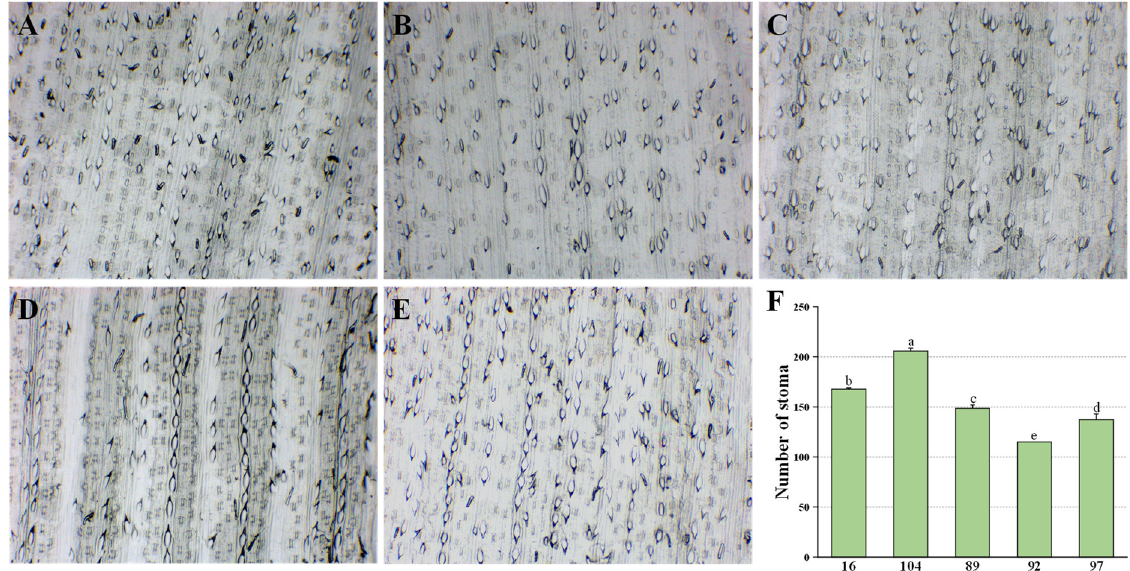
Figure 5. Microscopic observation of the stomata on sugarcane leaves in transgenic and control sugarcane lines. ( A ) 89; ( B ) 92; ( C ) 97, stomata on back of control sugarcane leaves observed by optical microscope with magnification 300X; ( D ) PPA−104; ( E ) PPA−16, stomata on back of transgenic sugarcane leaves observed by optical microscope with magnification 300X; ( F ) number of stomata on back leaves for each 1.285 mm 2 area. All data are presented as the mean of three replicates with standard error (SE). The letters (a–d) in the figures indicate a significant difference among stomata of experimental sugarcanes (one−way ANOVA, p < 0.05).